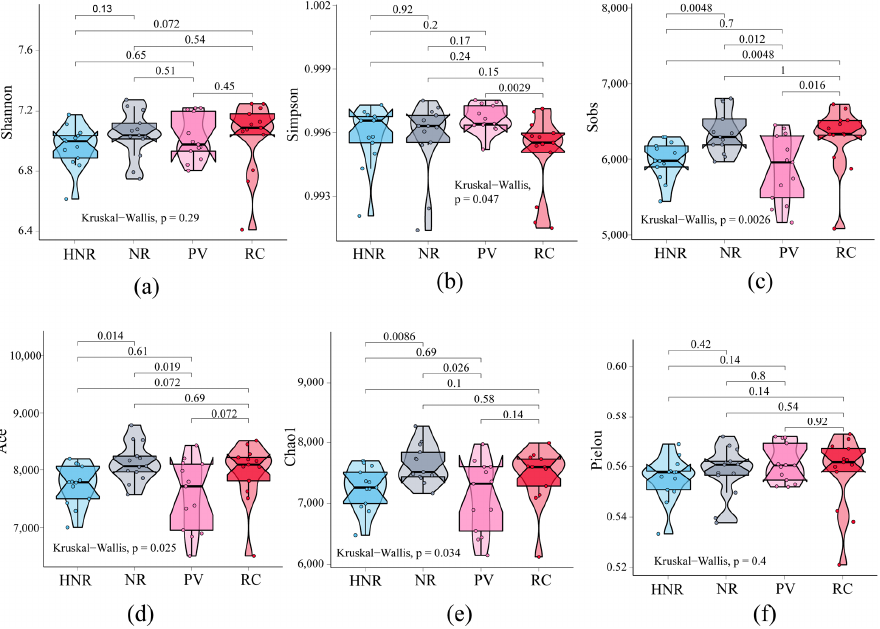
Figure 3. Diversity index analysis for different sampling points. ( a ) The Shannon Wiener diversity Index. ( b ) The Simpson’s diversity Index. ( c ) The Sobs richness Index. ( d ) The ACE richness index. ( e ) The Chao1 richness index. ( f ) The Pielou’s evenness Index.